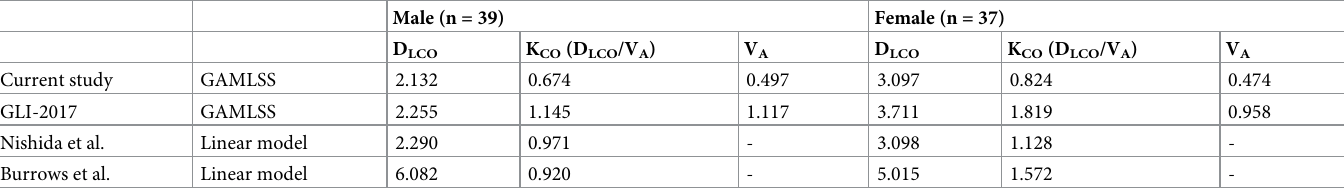
Table 5. Mean square errors of the D LCO , K CO , V A from our current equations, the GLI-2017 equation, and those by Nishida et al. and Burrows et